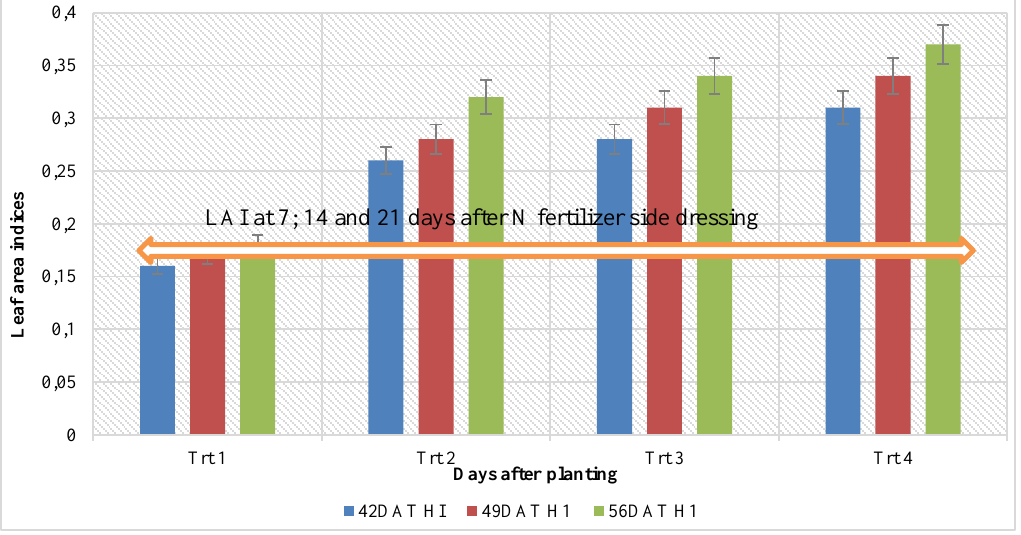
Figure 8a. LAI at 7; 14 and 21 days after N side dressing (2014)